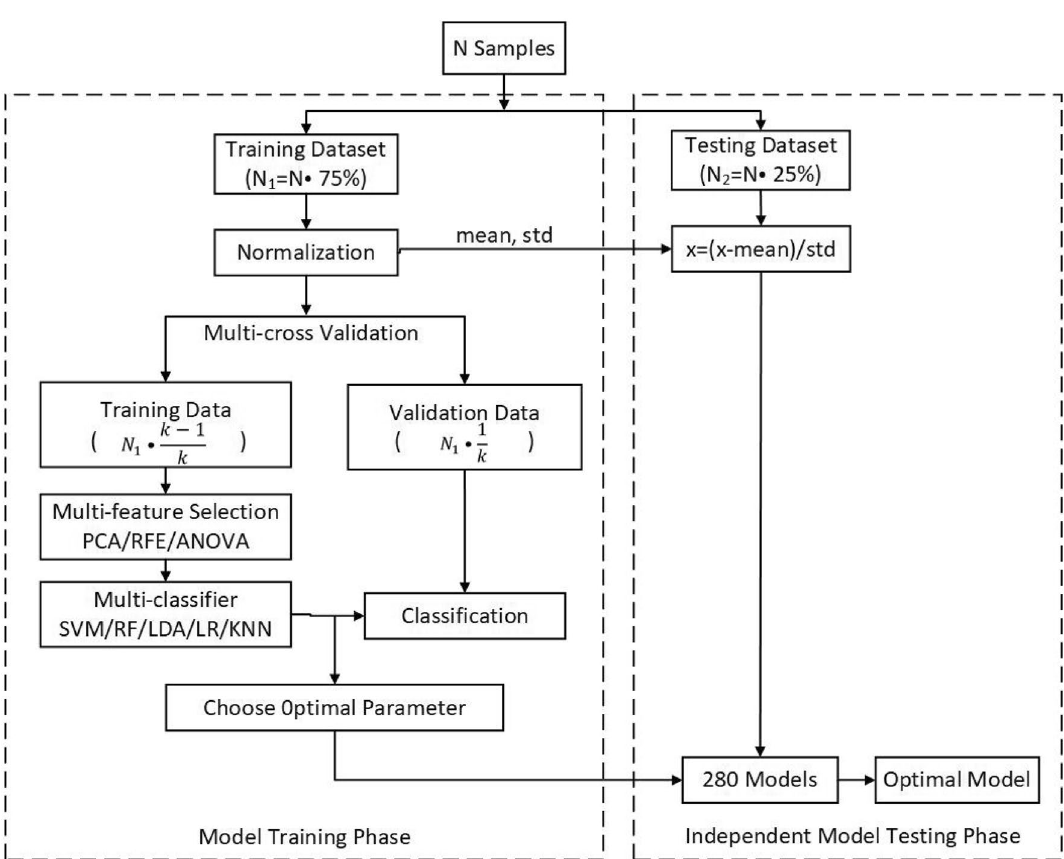
Figure 3. Flowchart of the machine learning classification